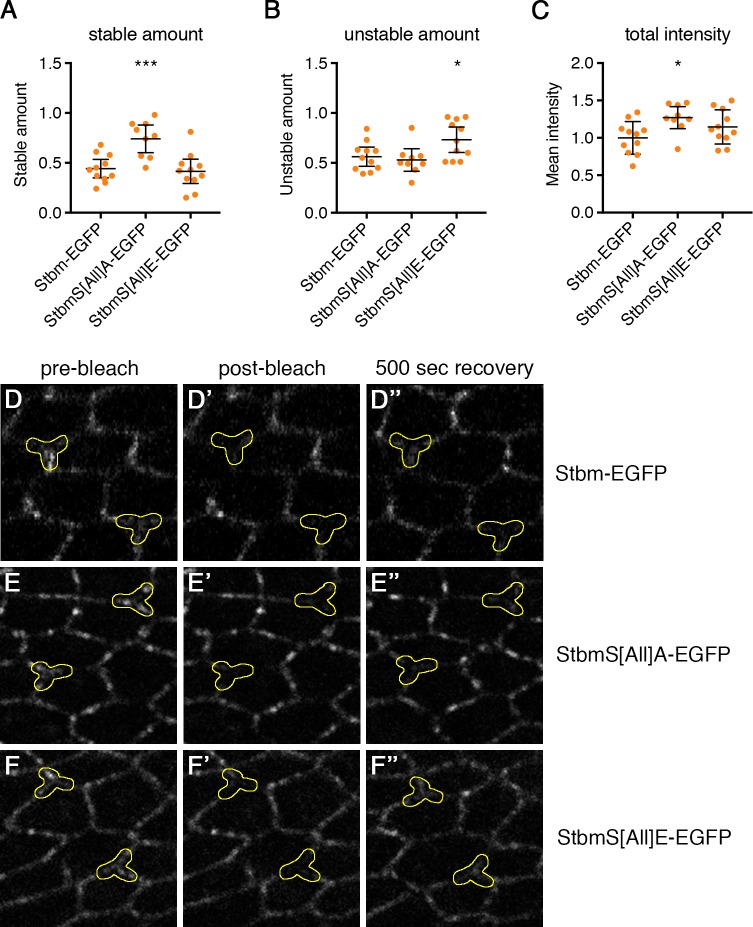
FRAP analysis of Stbm phosphomutant and phosphomimetic wings.(A–C) Stable amounts (A), unstable amounts (B) and total amounts (C) of EGFP-tagged protein at junctions in 28 hr APF pupal wings after hub-and-spoke FRAP (see Figure 4B). Data are normalised to the total intensity in Stbm-EGFP. Error bars are 95% confidence intervals, and ANOVA with Dunnett’s multiple comparisons test was used to compare levels to the Stbm-EGFP control, p≤0.05*, p≤0.001***. (D–F) Example images from the FRAP experiment in Figure 4B, before bleaching (left), immediately after bleaching (middle) and after 500 s recovery (right). Bleached regions are outlined in yellow. StbmS[All]A-EGFP (E) recovers less than Stbm-EGFP (D), while more recovery is seen for StbmS[All]E-EGFP (F).